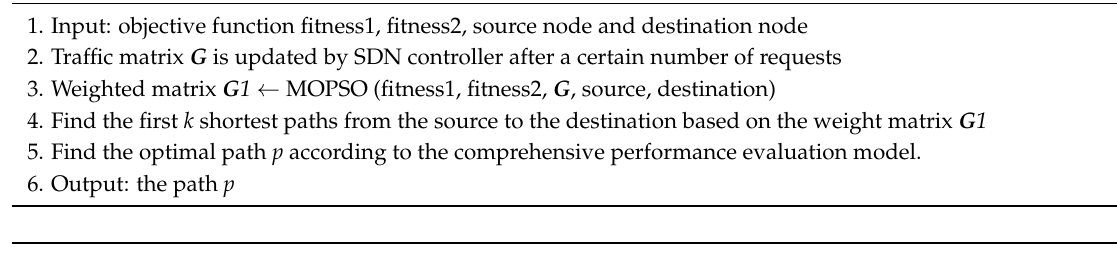
Algorithm 2: Find the optimal path